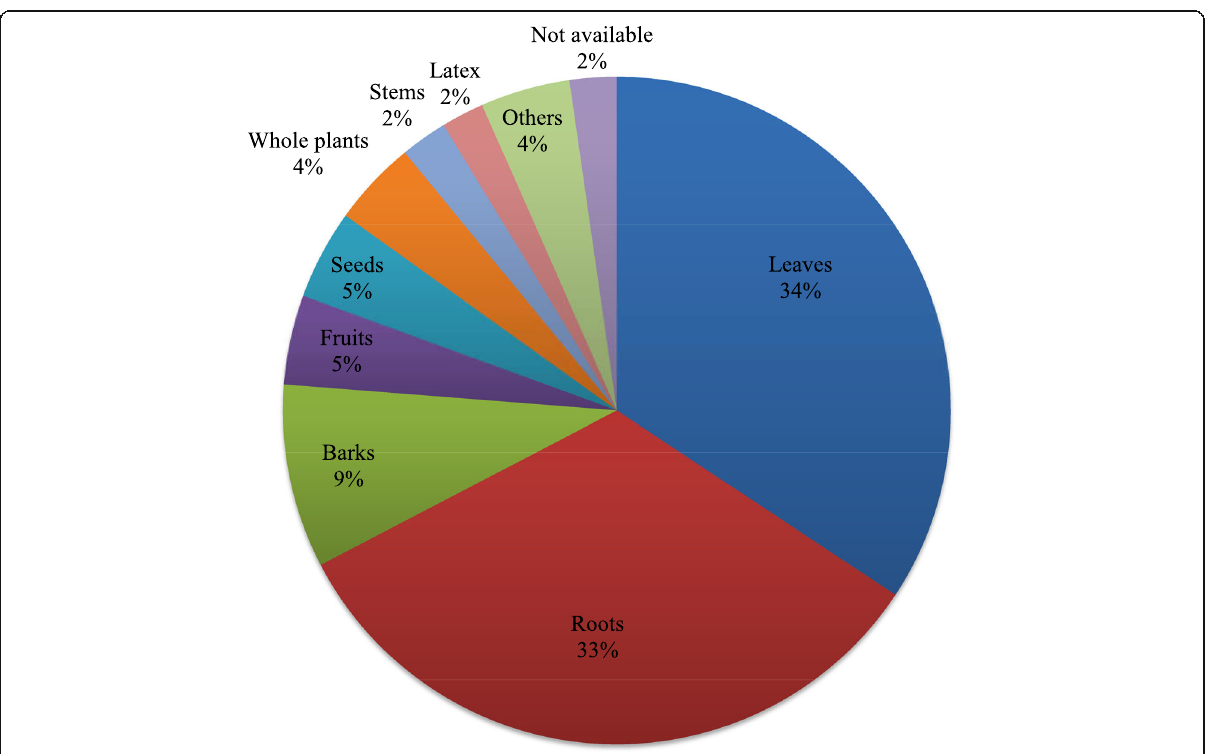
Fig. 3 Percentage of plant parts used for the treatment of hepatic disorders in